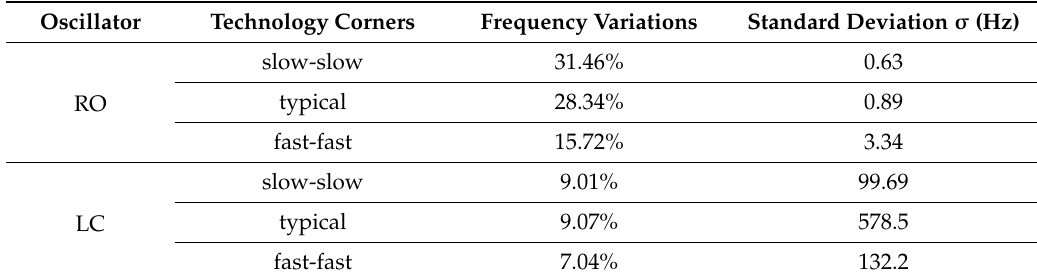
Table 1. Frequency variations and standard frequency deviation, respectively, for PVT (Process-Voltage- Temperature) and Monte Carlo simulations.